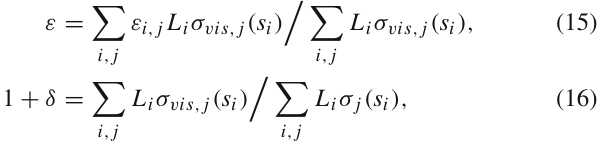
dominant mechanism is ρη . In the sum, we neglect the inter- ference between the amplitudes of the intermediate